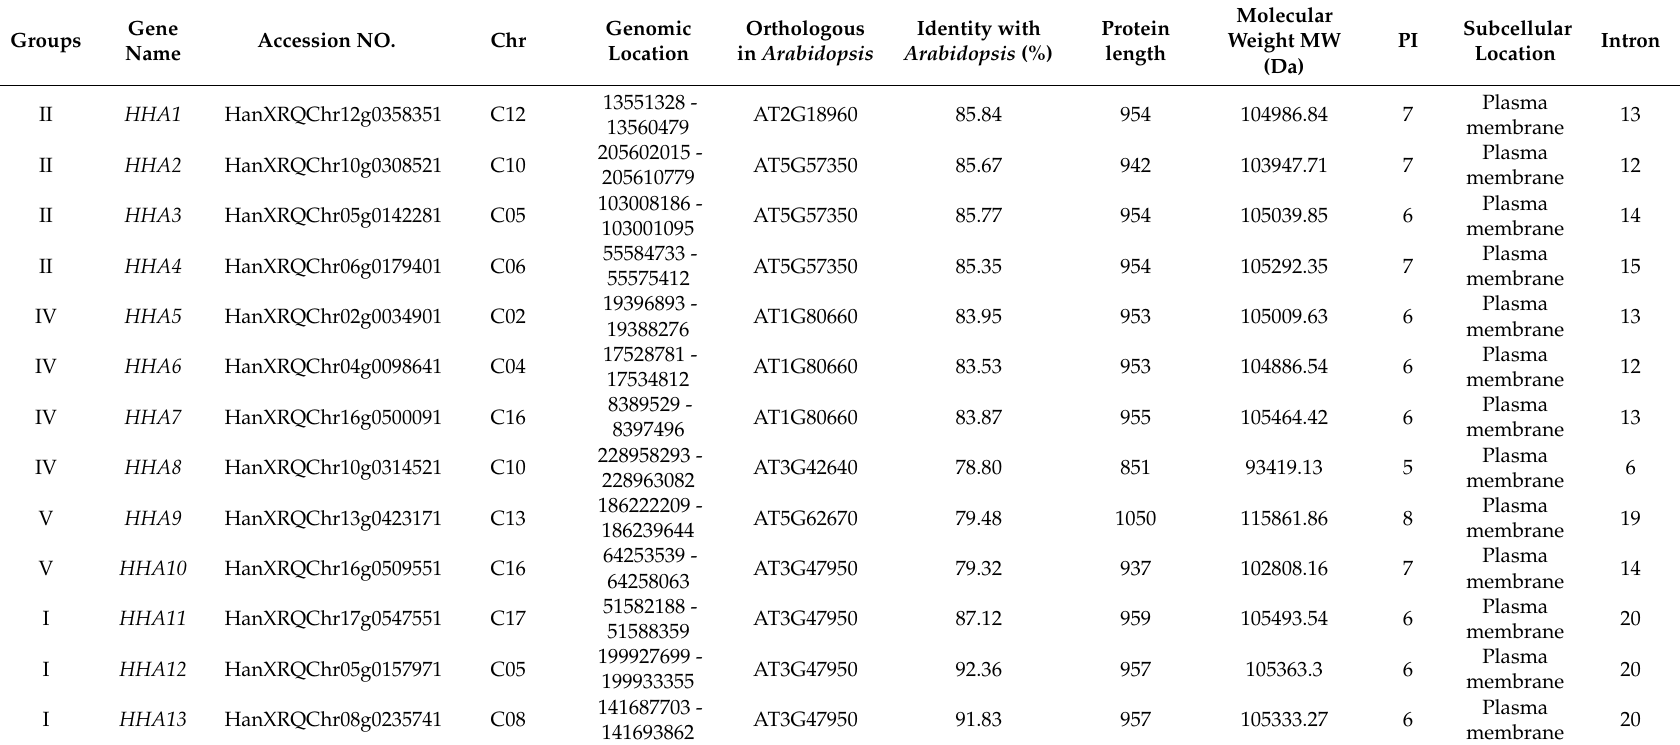
Table 1. Characteristics of plasma membrane (PM) H + -ATPase sub-gene family in